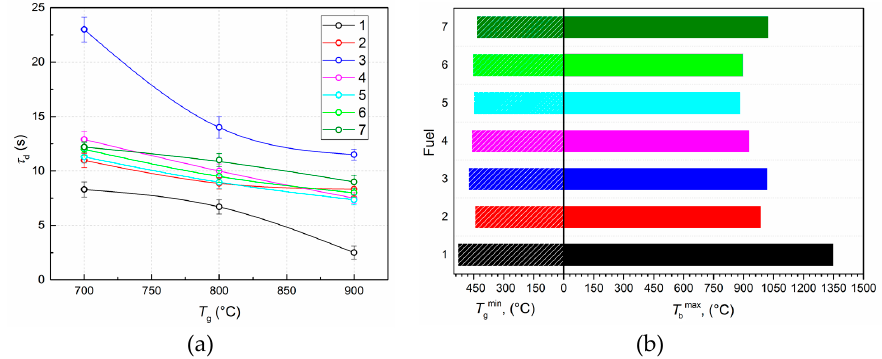
Figure 3. Ignition delay times of slurry droplets with biomass and coal vs. combustion chamber temperatures ( a ); threshold (minimum) ignition temperatures and maximum combustion temperatures of slurry droplets ( b ): 1%–100% coal; 2%–90% filter cake and 10% sawdust; 3%–90% filter cake and 10%